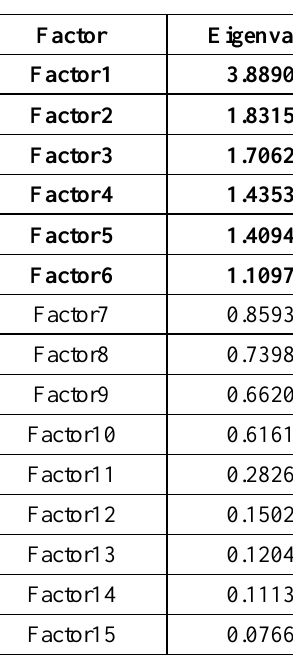
Table 4 . Factors and